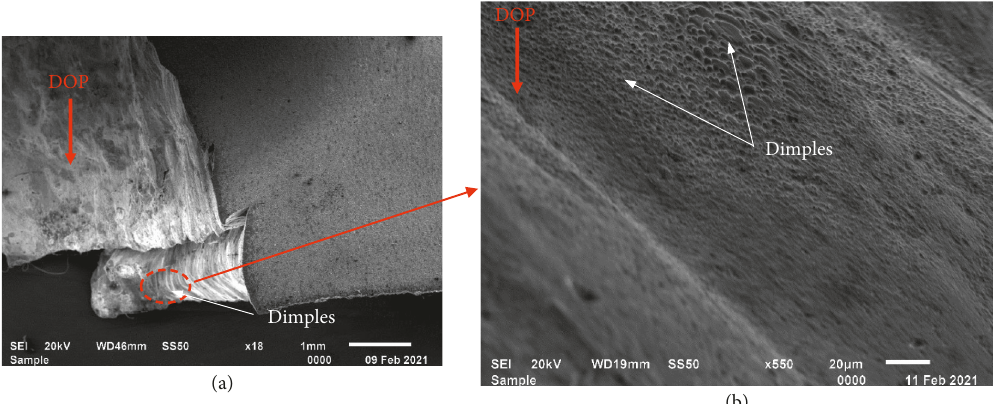
Figure 15: SEM SEI micrographs (a) at the exit point of the penetration hole through a 10mm thick plate and (b) a higher magnification micrograph of the area indicated in